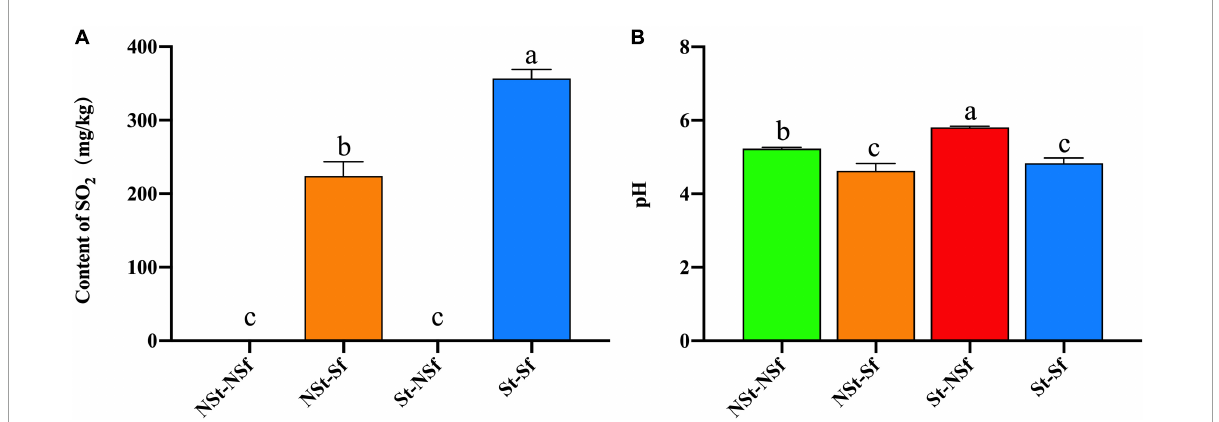
FIGURE1 Residual sulfur dioxide content after processing of Gastrodia elata (A) , Effect of steaming and sulfur fumigation on the pH of G. elata powder (B) . NSt-NSf, nonsteam and nonsulfur fumigation treatment; NSt-Sf, nonsteam and sulfur fumigation treatment; St-NSf, steam and nonsulfur fumigation treatment; St-Sf, steam and sulfur fumigation treatment.